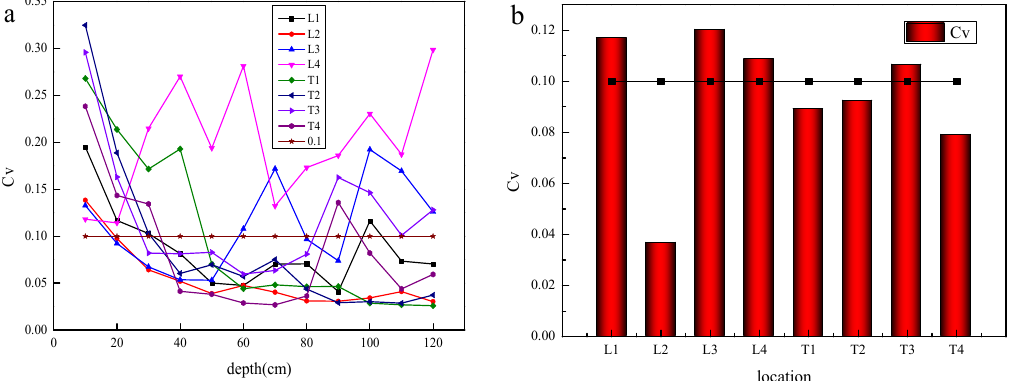
Figure 4. Coefficient of variation for ( a ) soil moisture between rows and between trees within the row at different depths and ( b ) annual average soil moisture data for different probes.